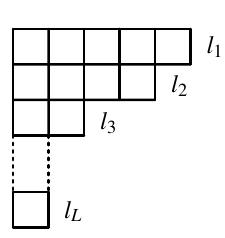
Figure 3. Young diagram associated with the representation labeled by integers l 1 ≥ l 2 ≥ · · · ≥ l L where l represents the length of the ν -th row of the ν